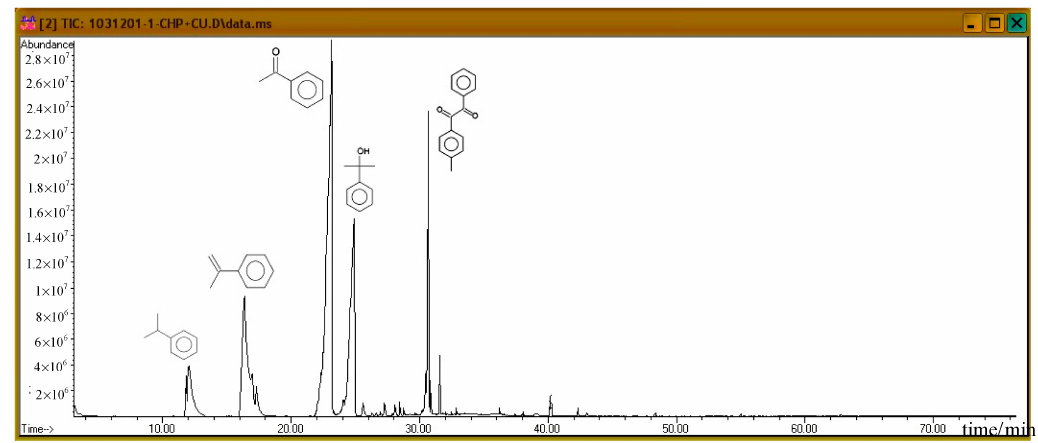
Figure 9. Product analysis of CHP decomposition after mixing CHP with CuBr 2 by GC/MS.